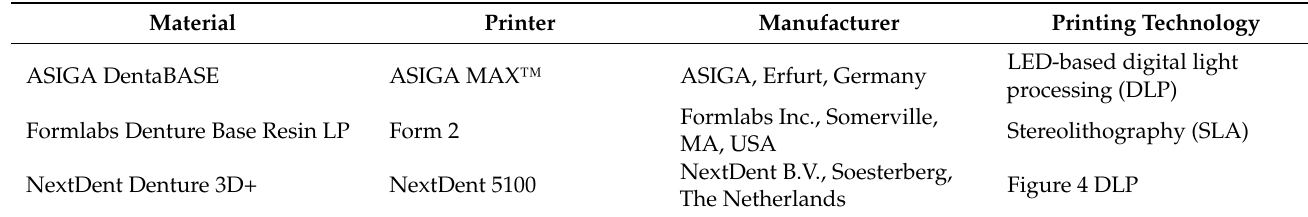
Table 2. Printing parameters used.